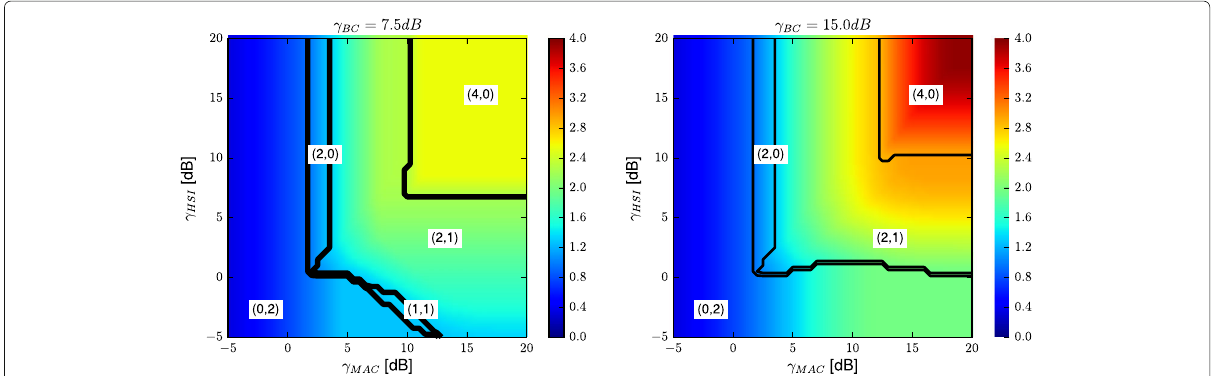
Fig. 14 Maximal encoded system throughput T max